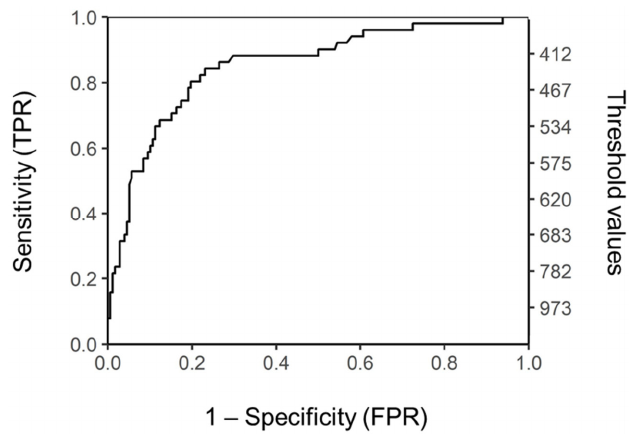
Figure 2. ROC curve for platelets as binary classificatory and thrombocytosis as a class variable. Threshold values are presented on the right axis (scale is not linear).